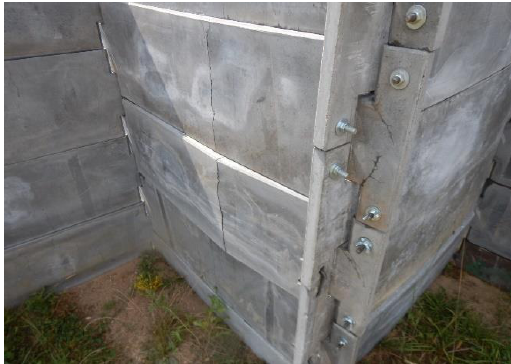
Figure 19. Post-test picture showing crack propagation on the distal face of the UHPFRCC wall.